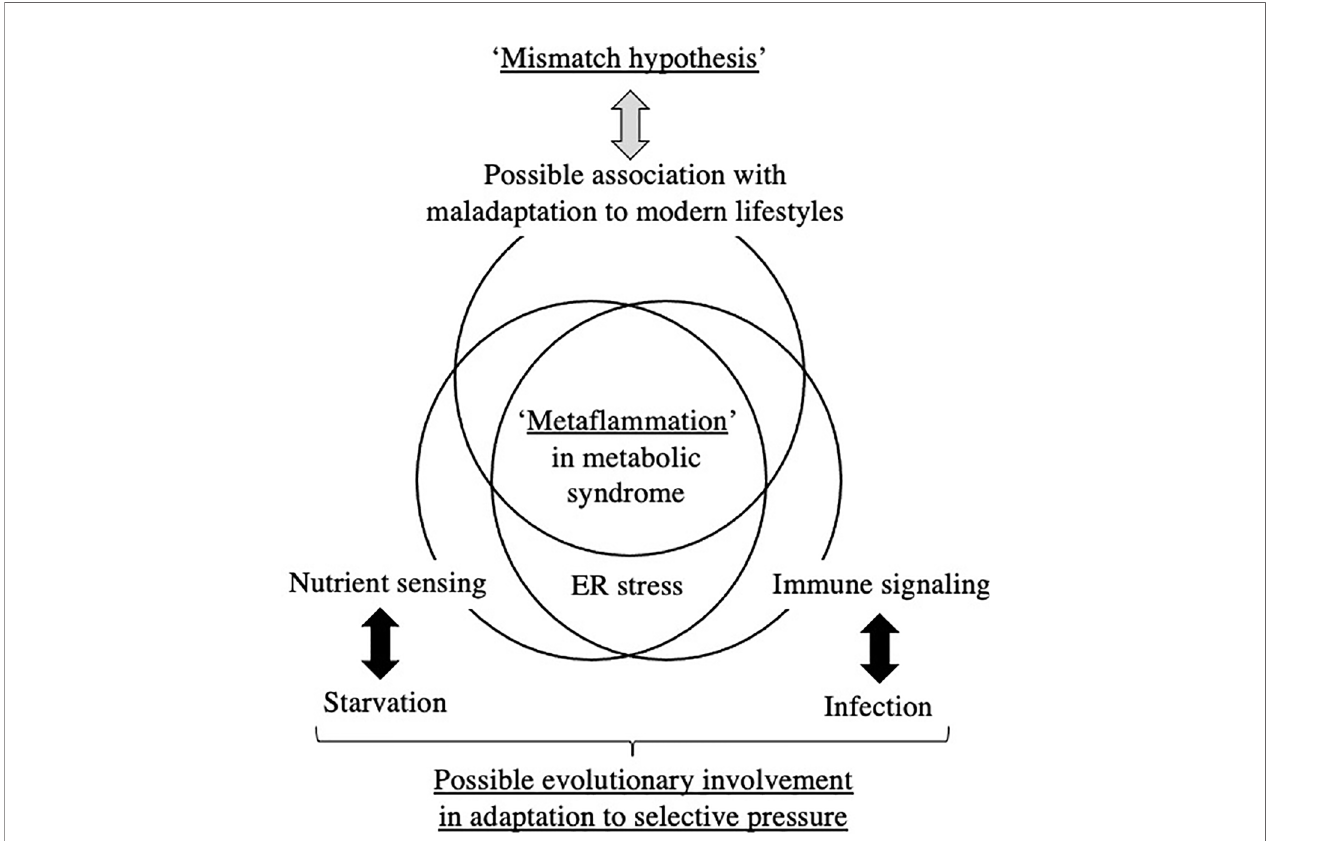
FIGURE 2 | Hypothetical understanding of ‘ Meta fl ammation ’ in metabolic syndrome from the viewpoint of the DOHaD theory and evolutionary biology. ER; endoplasmic